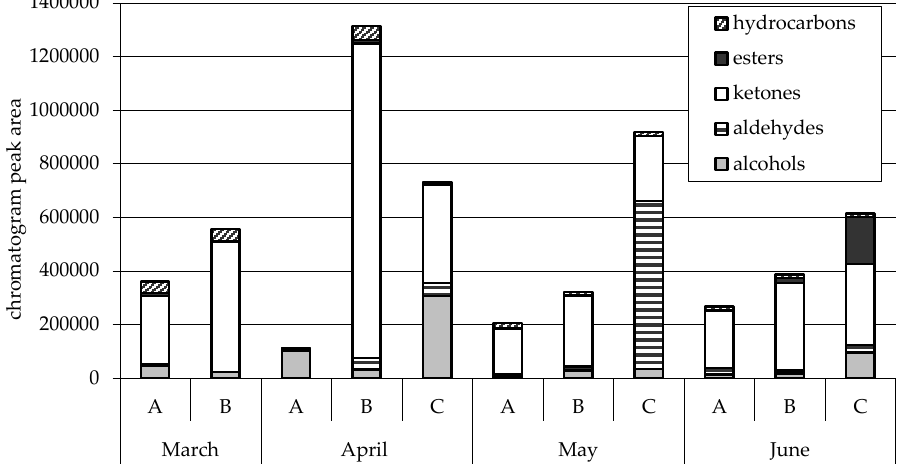
Figure 9. E ff ect of di ff erent feeding goat system (A = stall-fed with hay and concentrate; B = woody and herbaceous species with small amount of supplements; C = only herbaceous species with small amount of supplements) on volatile compounds